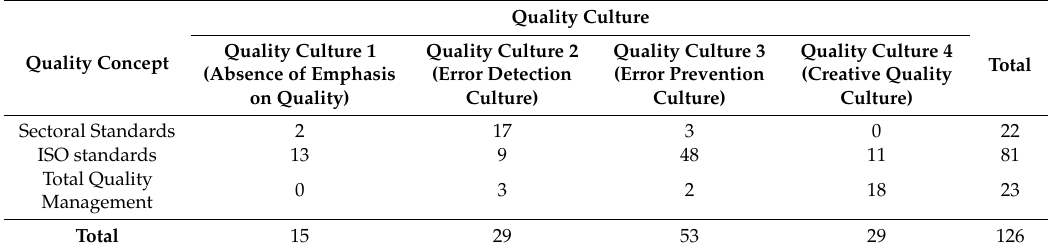
Table 1. Cross-tabulation of quality culture and quality concept (observed counts).